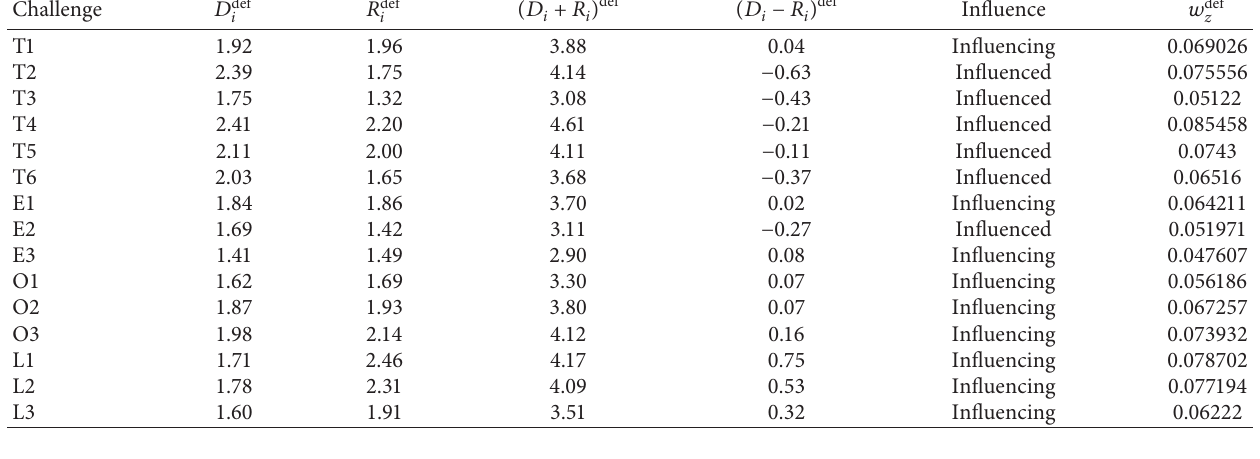
, R def , ( 􏽥 D + 􏽥 R ) def , ( 􏽥 D i i i i